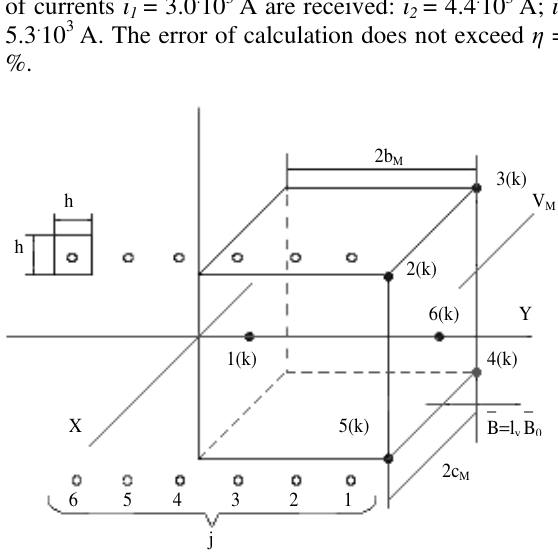
Fig 13. Explanatory scheme for formation of linear equations system